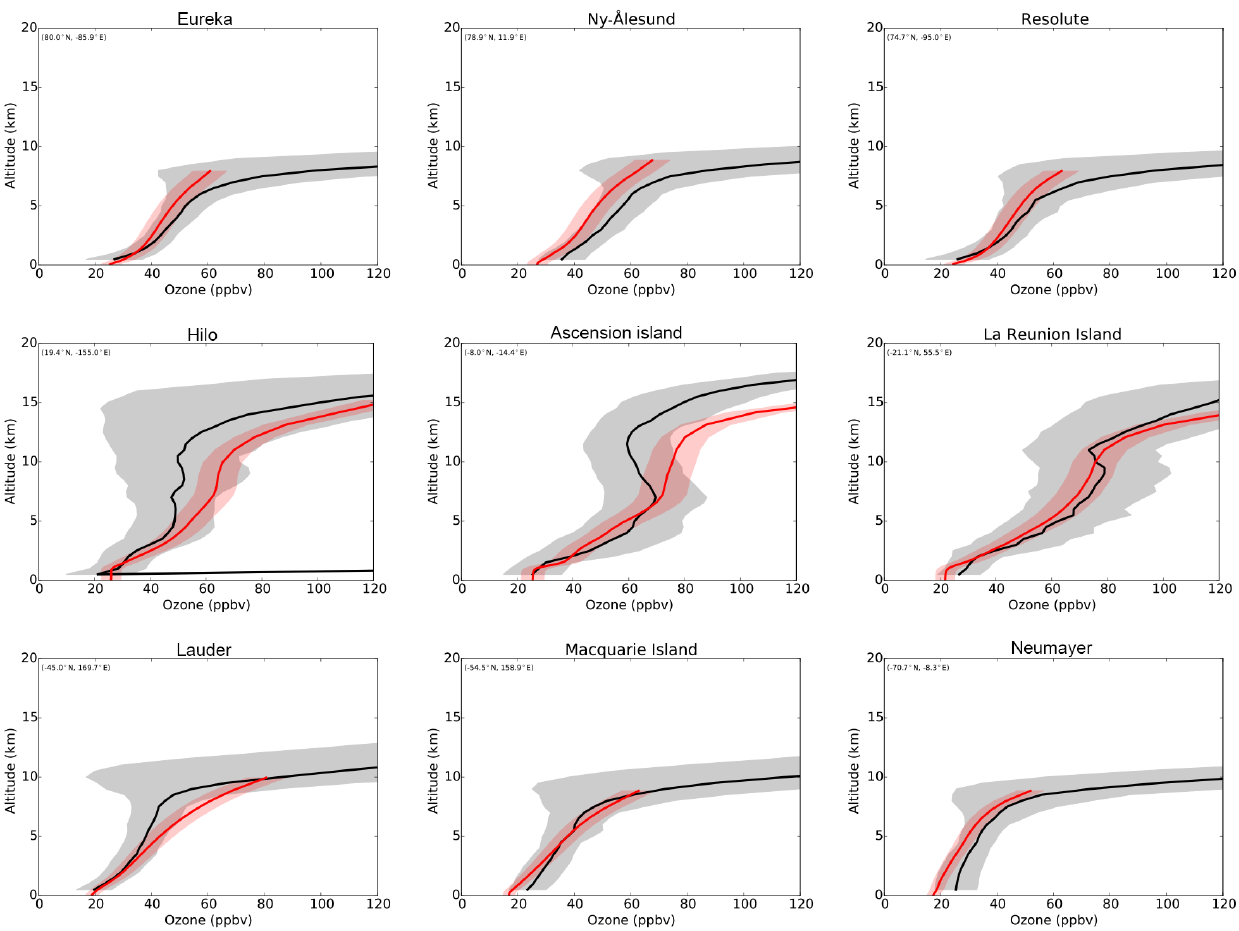
Figure 14. Ozonesondes: comparisons between the variability of annual ozonesonde measurements and model data with uncertainties. The black line shows the annual mean observation data and the shaded gray area shows the range of data. The red line shows the model data and the pink shaded line shows the chemical 1 σ uncertainty. Observations are obtained from WOUDC